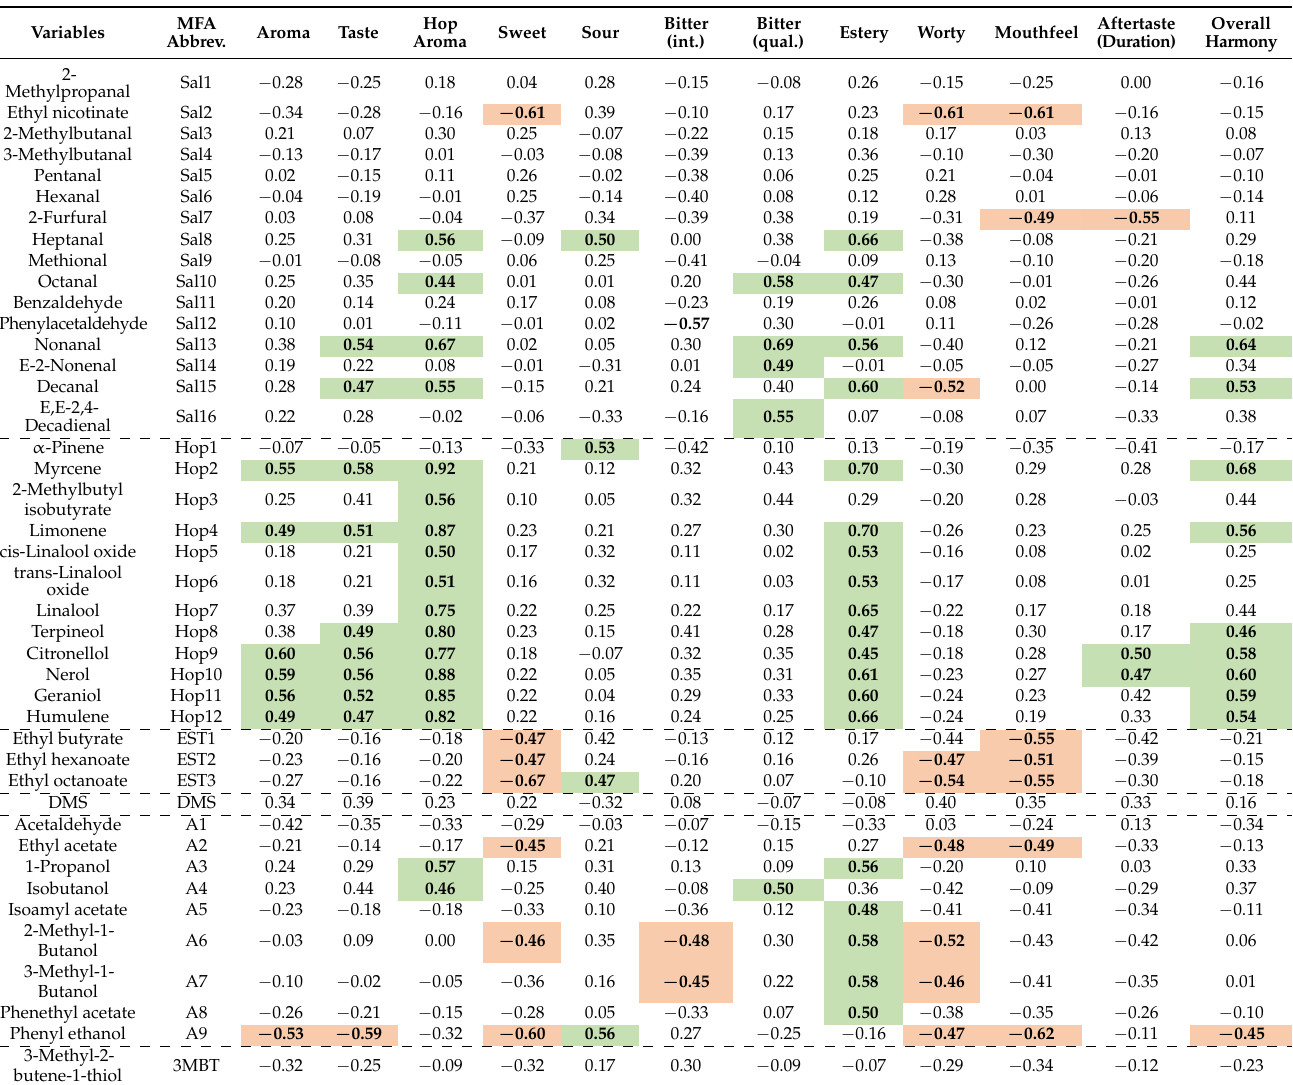
Table 2. Pearson correlation coefficients between sensory and volatile